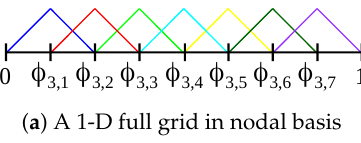
Figure 3. The nodal and the sparse grid in Figure 3a,b both have discretization level l = 3 and are equal for d = 1. Both use hat functions φ l , i as basis functions, but in a nodal and in a hierarchical formulation. Note that sparse grids employ less grid points compared to full grids of the same level for d ≥ 2 (see Figure